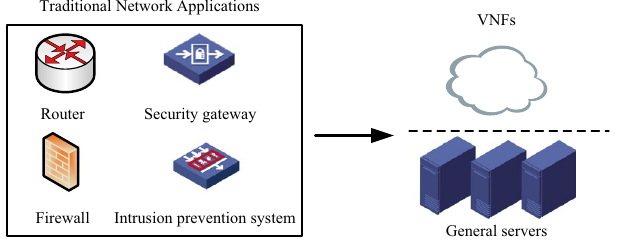
Figure 1. Network function virtualization